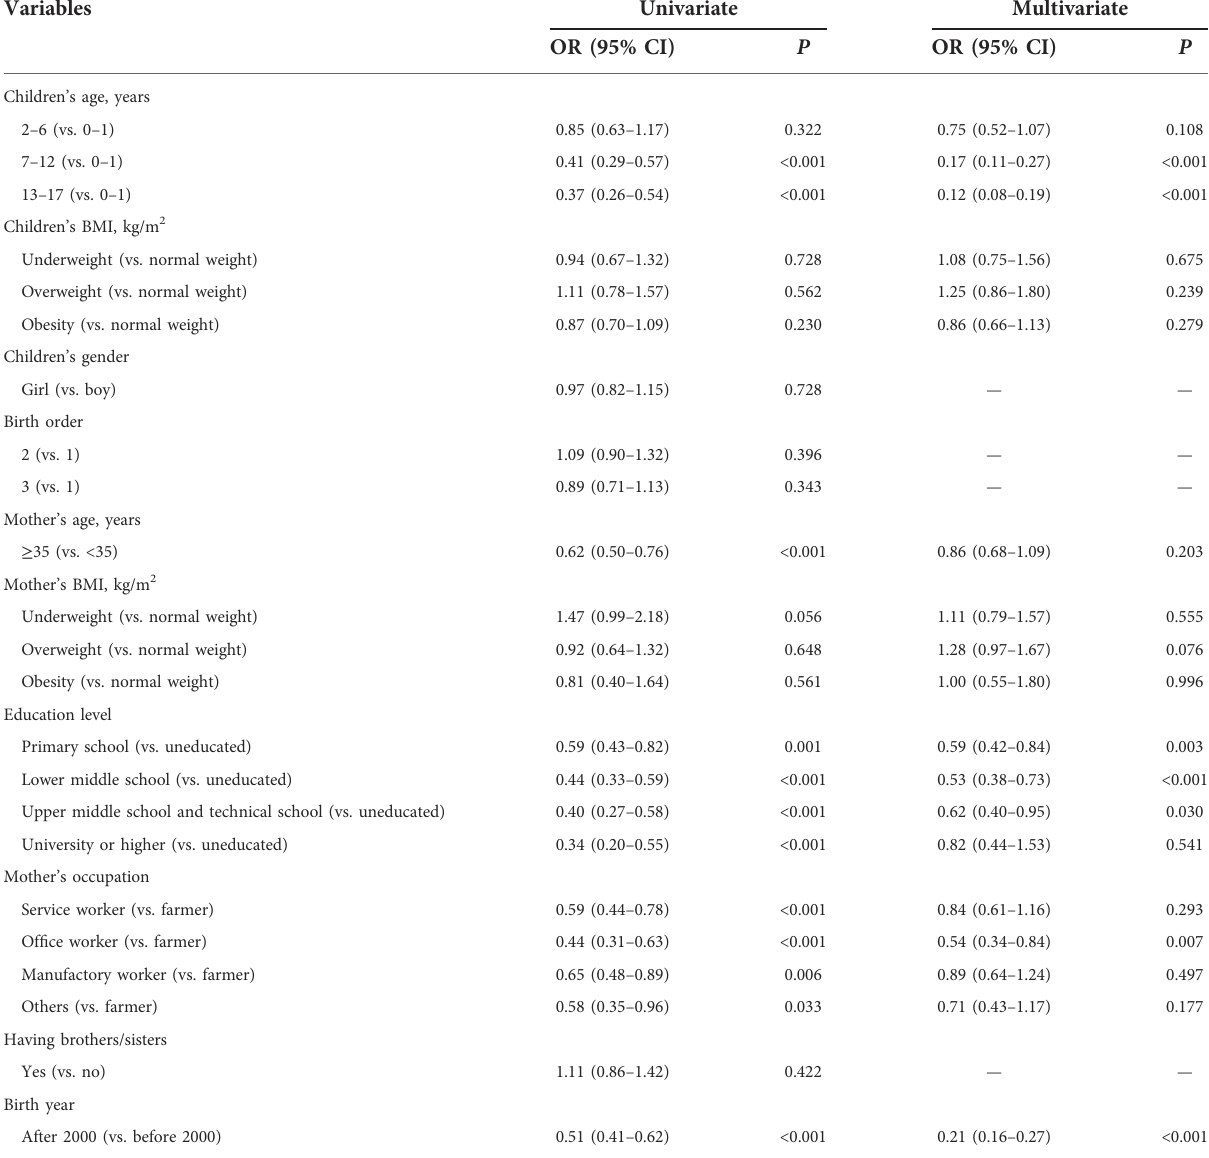
TABLE 2 Exploring in fl uence factors for URTI in rural